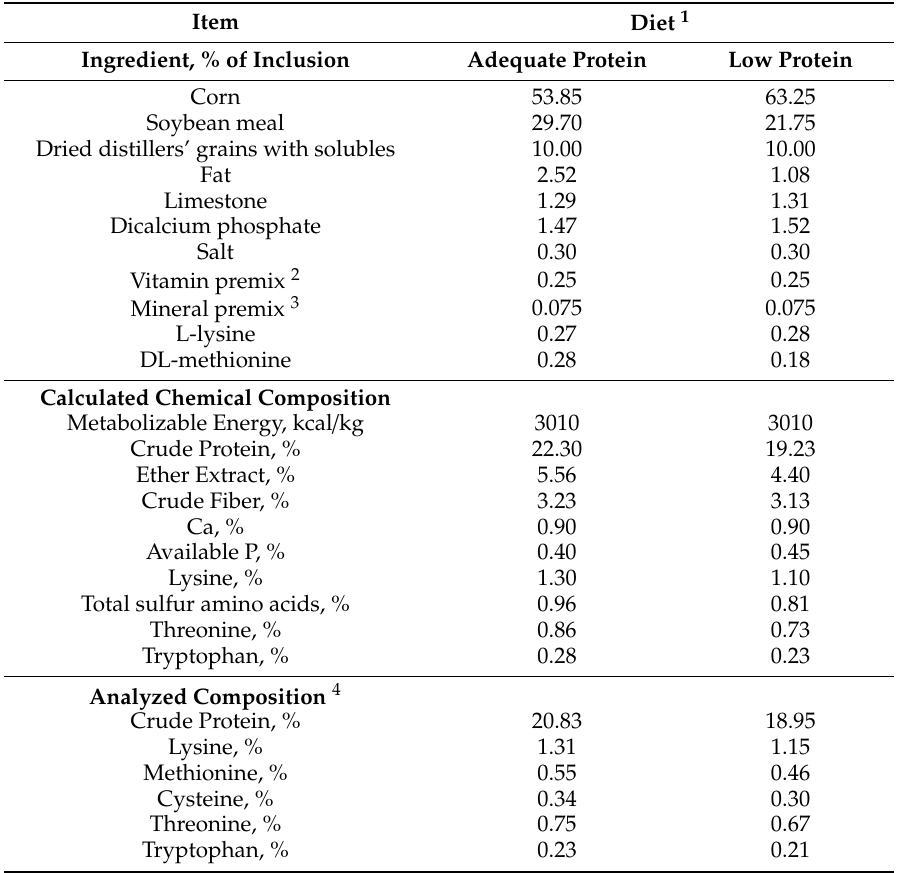
Table 1. Composition and nutrient contents of the diets o ff ered to